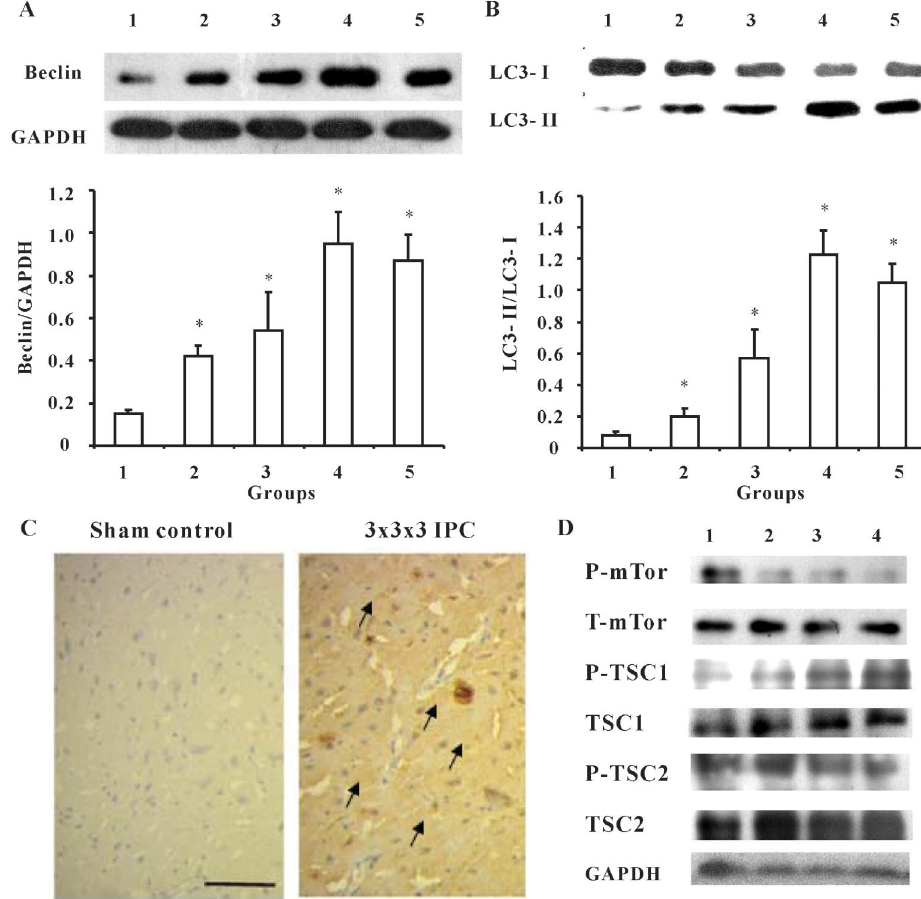
Figure 1. Ischemic preconditioning (IPC) activates autophagy in control rats 24 h after surgery. A , IPC increased Beclin expression. B , IPC increased LC3 conversion. Data are reported as means±SE of 4 rats in each group. *P , 0.05, compared to sham control group (one-way ANOVA followed by the Bonferroni test). Groups: 1) sham control, 2) 5 min IPC, 3) 5 6 5 min IPC, 4) 5 6 5 6 5 min IPC, and 5) 15 min IPC. C , Representative images of immunohistochemistry of LC3B (bar: 40 m m). Arrows indicate the cytoplasmic expression of LC3B. D , Expression of TSC-mTor pathway related proteins. IPC increased phospho-TSC1 (P-TSC1), while it decreased phospho- mTor (P-mTor) levels in an episode-dependent manner, whereas total mTor, TSC1, TSC2, and P-TSC2 were not affected by IPC. TSC1: tuberous sclerosis type 1; TSC2: tuberous sclerosis type